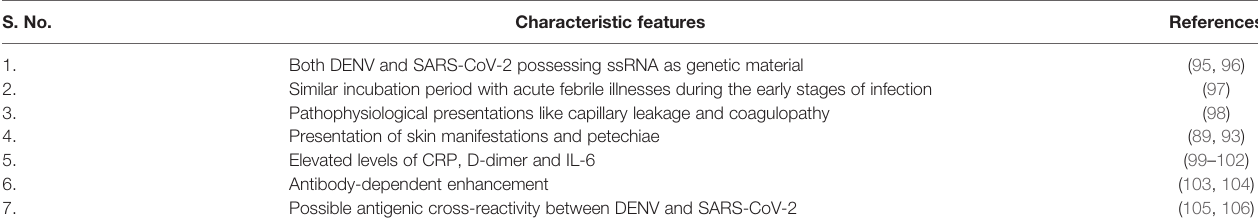
TABLE 1 | Similarities in characteristics between dengue infection and